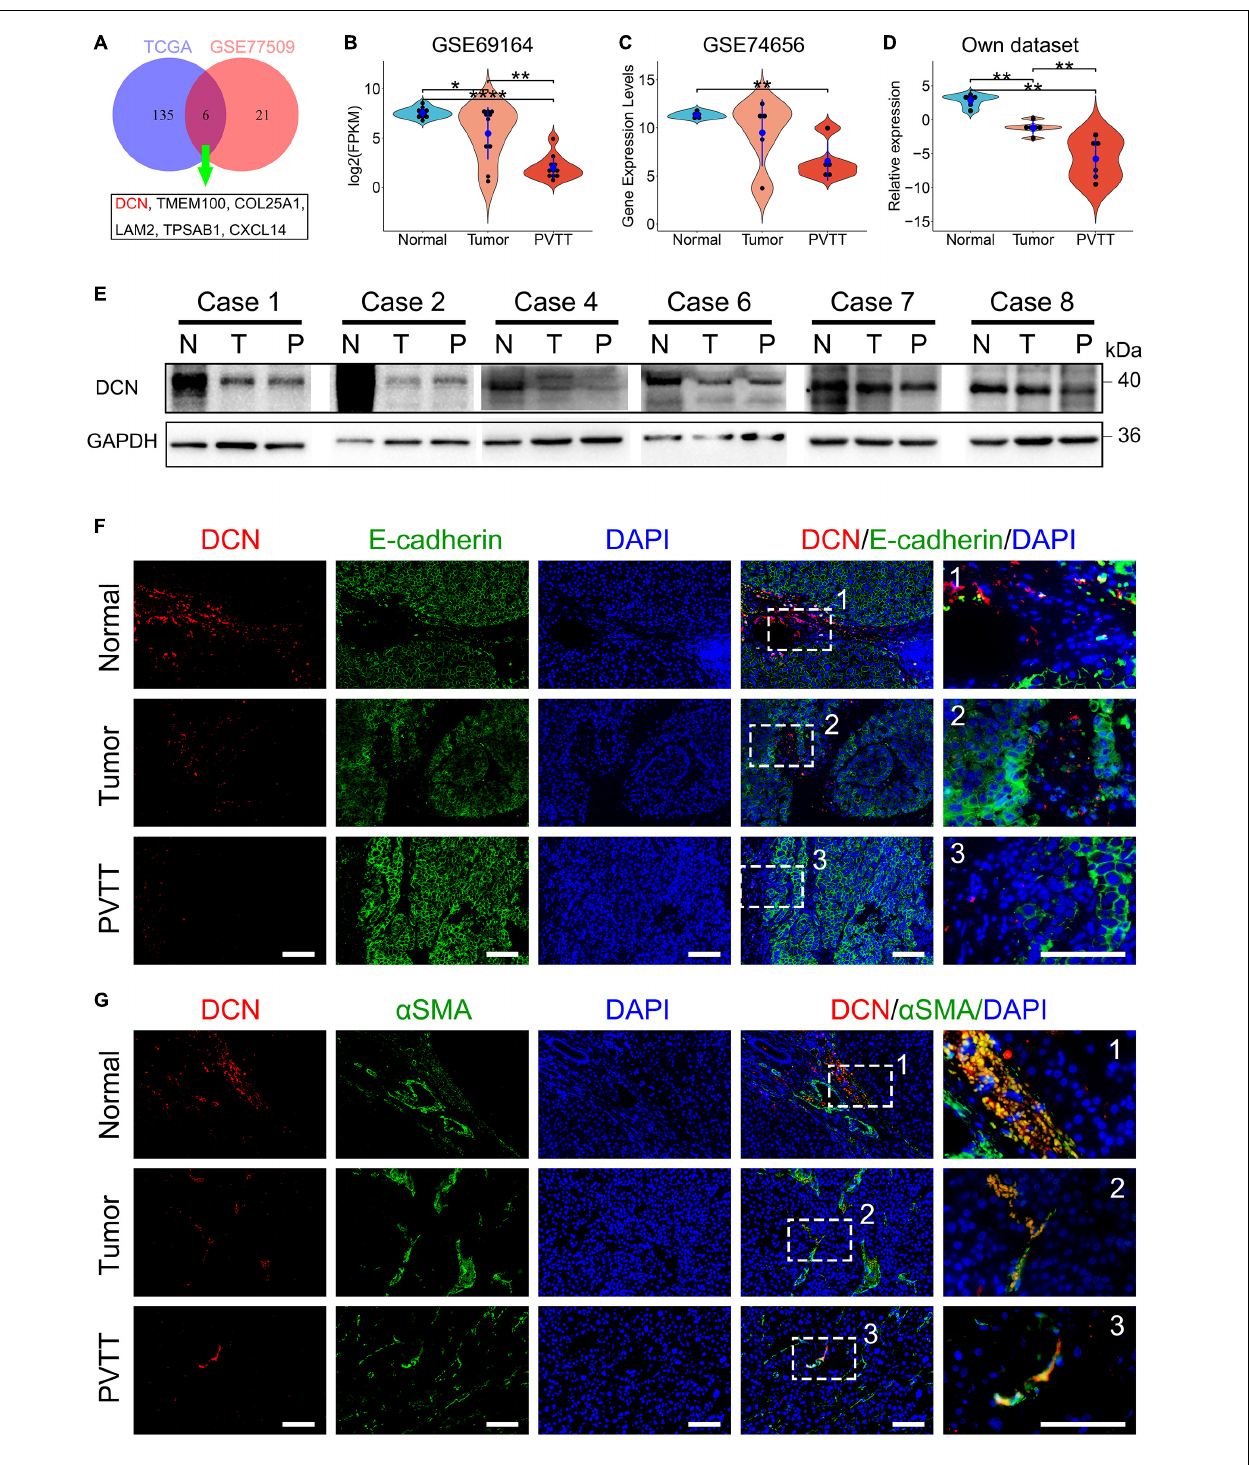
FIGURE 2 | DCN secreted by CAFs is gradually downregulated during HCC progression. (A) Venn diagram of DEGs enriched in ECM-related pathways between public dataset GSE77509 and TCGA. (B–D) Relative mRNA expression of DCN among normal tissue, tumor tissue, and PVTT tissue in the GEO datasets GSE69164 (B) , GSE74656 (C) , and our dataset (D) . (E) DCN protein expression in normal tissue (N), tumor tissue (T), and PVTT (P) tissue as obtained by immunoblot analysis. (F,G) Co-immunofluorescence staining of DCN with E-cadherin (F) and DCN with α -SMA (G) was performed in normal tissue, tumor tissue, and PVTT tissue. Scale bar, 100 µ m. α -SMA, alpha-smooth muscle actin; PVTT, portal vein tumor thrombosis. TCGA, The Cancer Genome Atlas. Data presented as mean ± SEM. * P < 0.05, ** P < 0.01, and **** P < 0.0001, Student’s t -test.